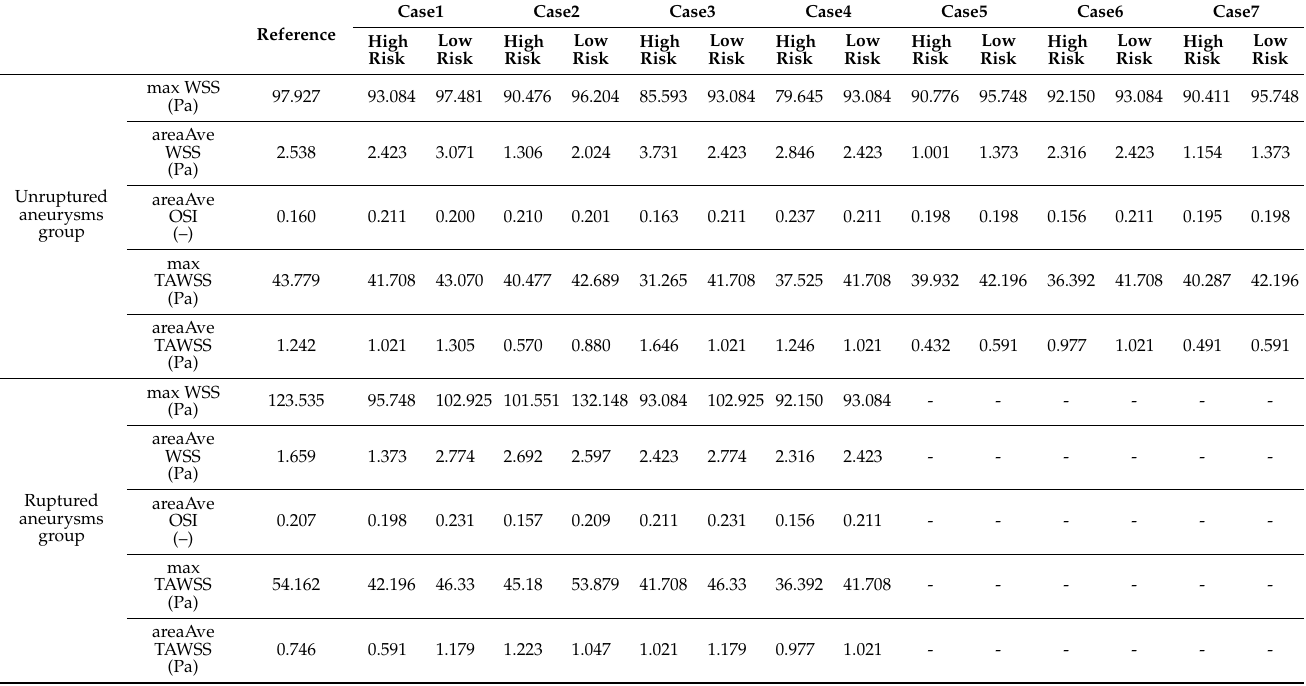
Table 5. Hemodynamic